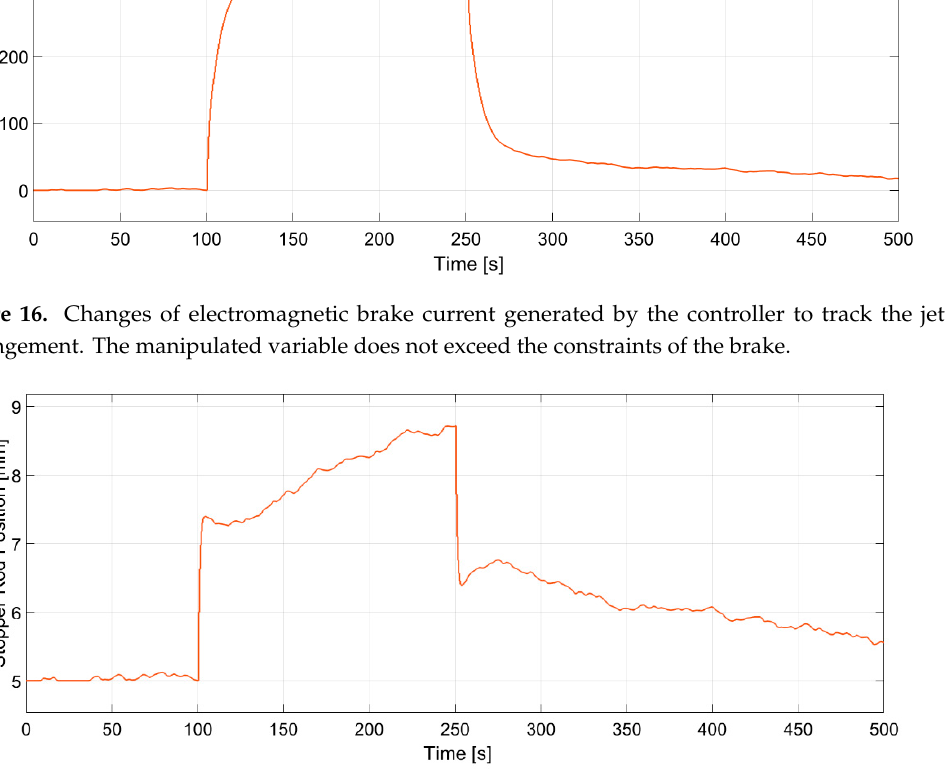
Figure 17. Changes of the stopper rod position generated by the controller to track the jet velocity. The manipulated variable does not exceed the constraints of the stopper rod.